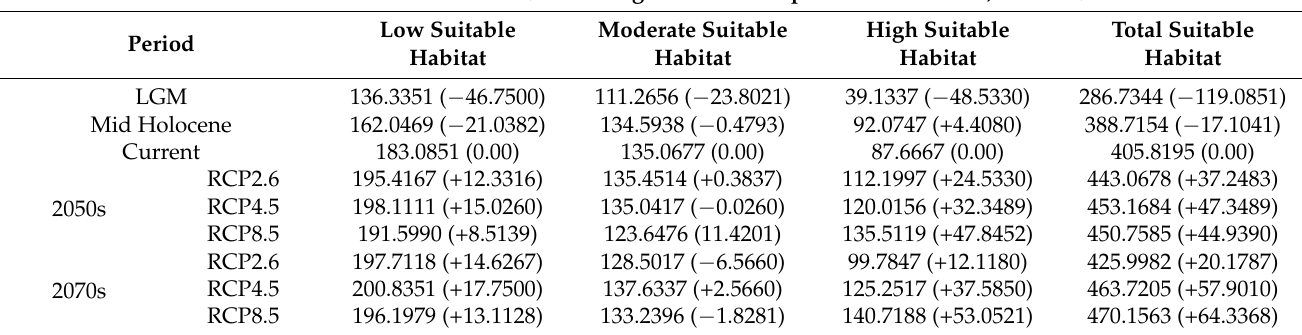
Table 4. The area of each suitable region of Morchella in different periods.